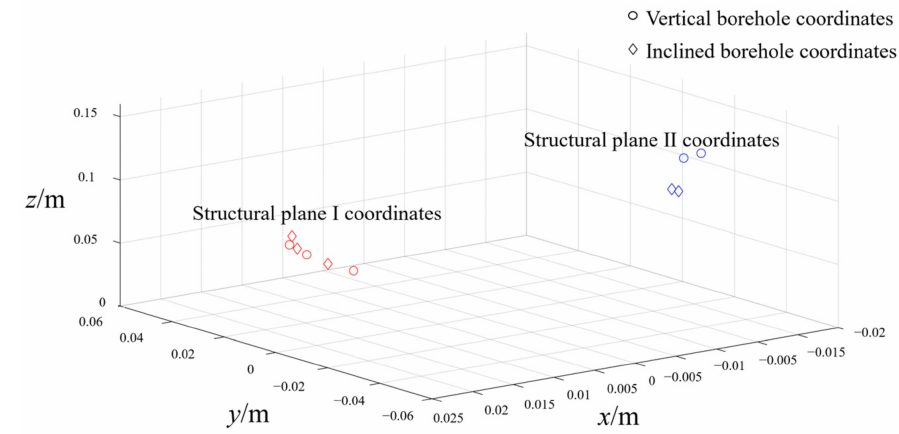
Figure 12. Coordinates diagram of the structural plane in sample 1.